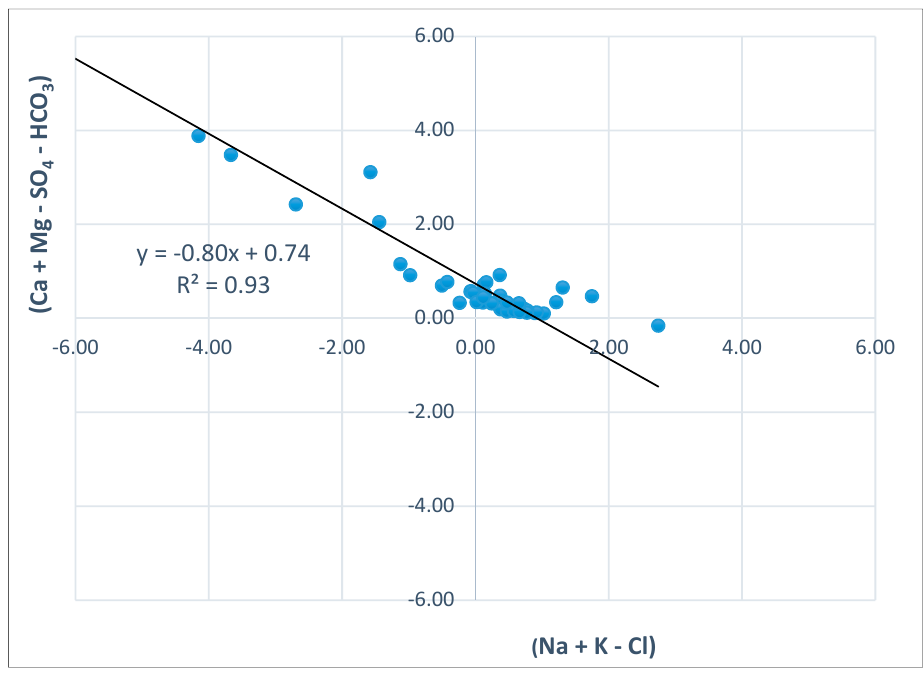
Water 2021 , 13 , x FOR PEER REVIEW Figure 9. Plot of (Ca+Mg-SO 4 -HCO 3 ) and (Na+K-Cl) in meq/L. Figure 9. Plot of (Ca+Mg-SO 4 -HCO 3 ) and (Na+K-Cl) in meq/L. According to [58] the plot of (Ca + Mg) vs. (SO 4 + HCO 3 ) could be a reliable indica-